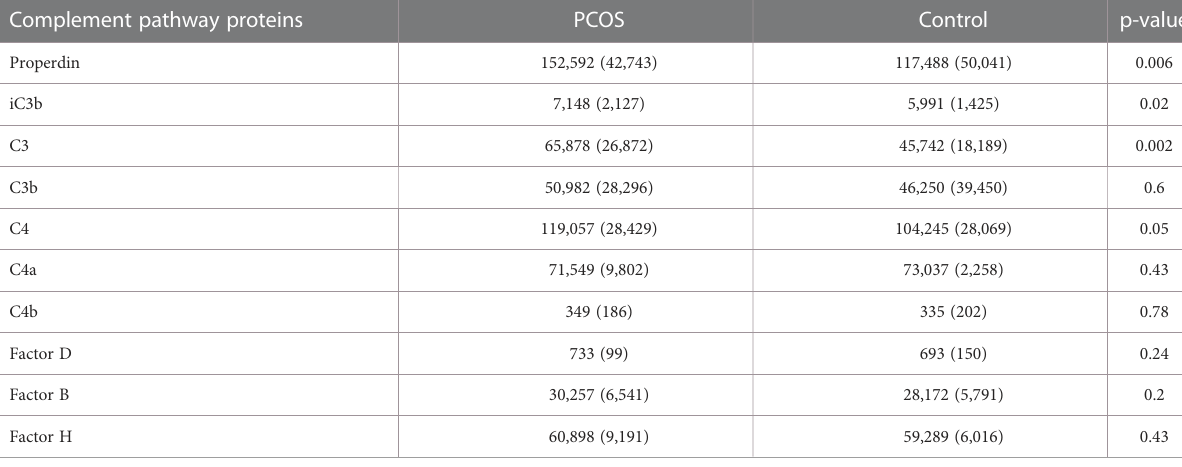
Complement proteins for the classical (C4, C4a, and C4b) and alternative (C3, iC3, Properdin, Factors B, D, and H) complement pathways in non-obese non-insulin resistant women with polycystic ovary syndrome (PCOS) versus their BMI-matched controls. Data presented as Mean ± 1 Standard Deviation of Relative Fluorescent Units